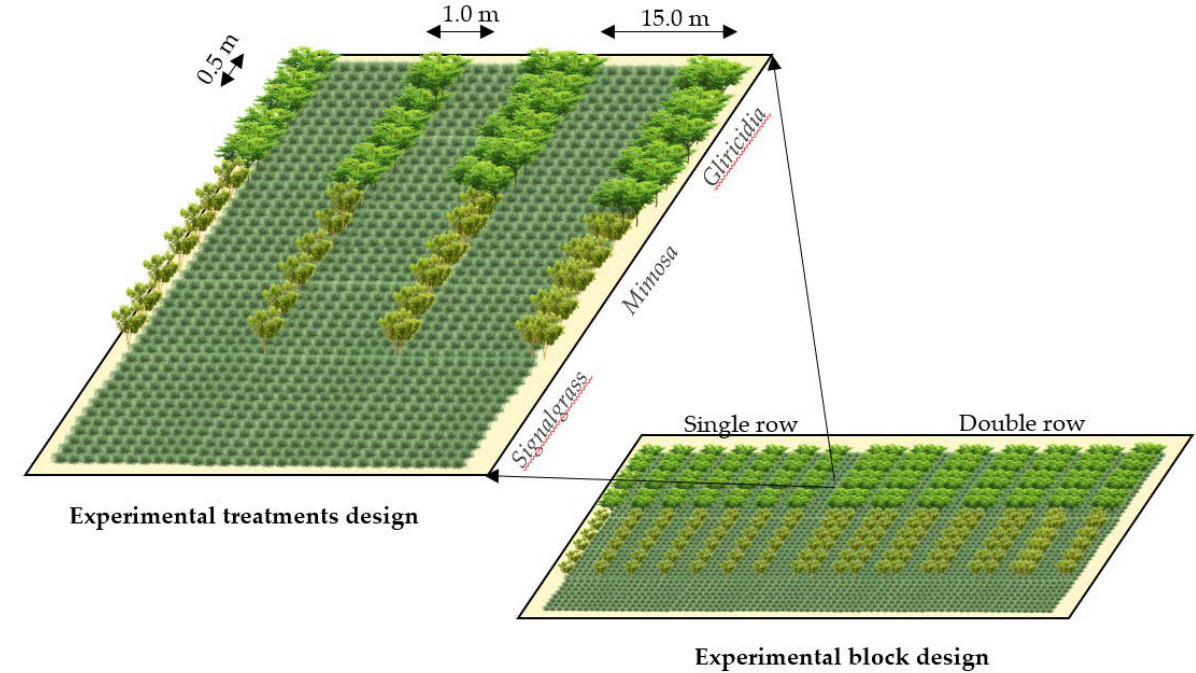
Figure 1. Experimental design of one block with three experimental